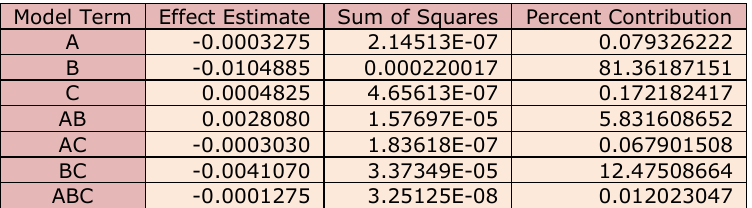
Table 2. Factor effect estimates and sums of